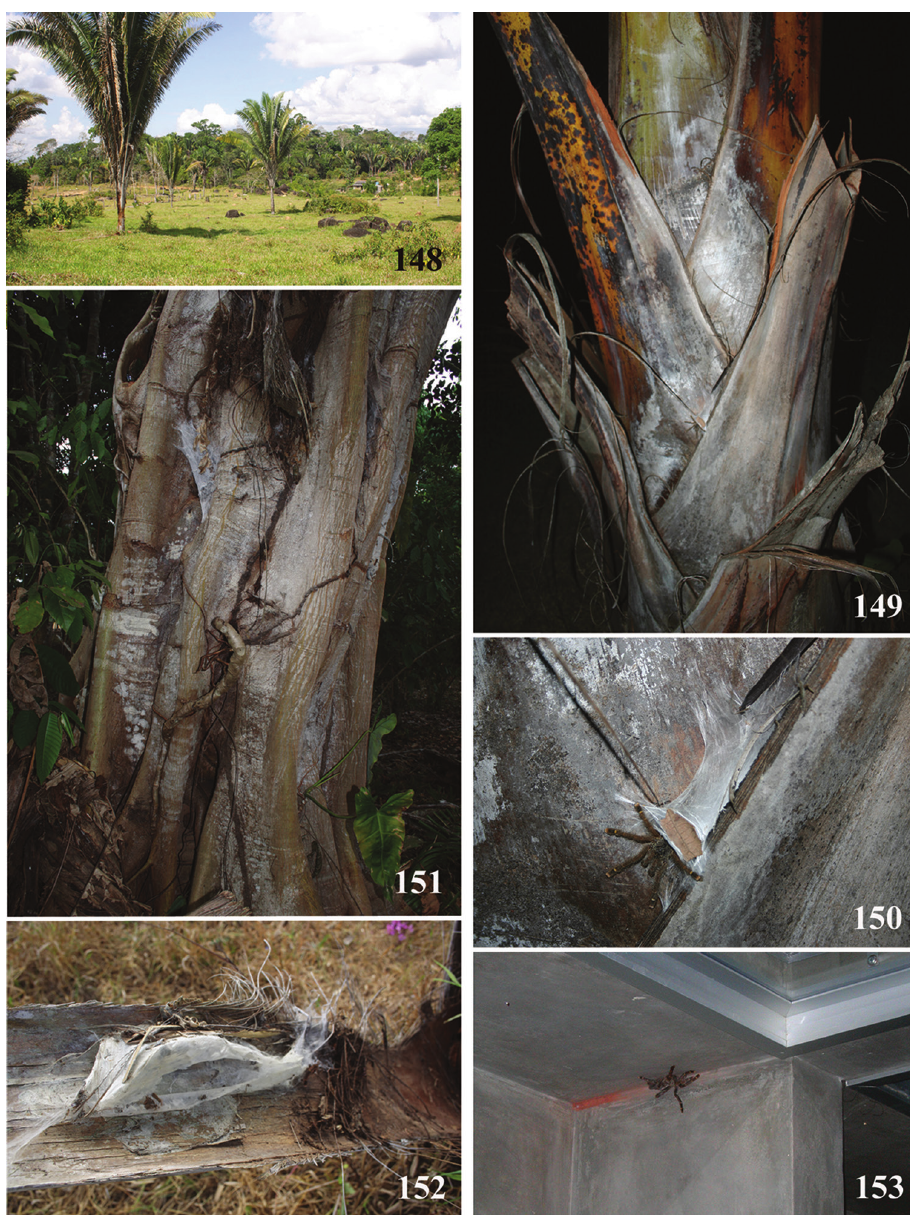
Figures 148–153. Avicularia rufa Schiapelli & Gerschman, 1945, habitat and retreats. 148 Babaçu palms, a common habitat of A. rufa in state of Rondônia, Brazil 149 retreat of immature on a palm tree 150 detail of retreat 151 retreat over a tree bark 152 use of intern side of babaçu palm to build retreat 153 in human buildings. Photos: 148–152 R. Bertani; 153 C. S.